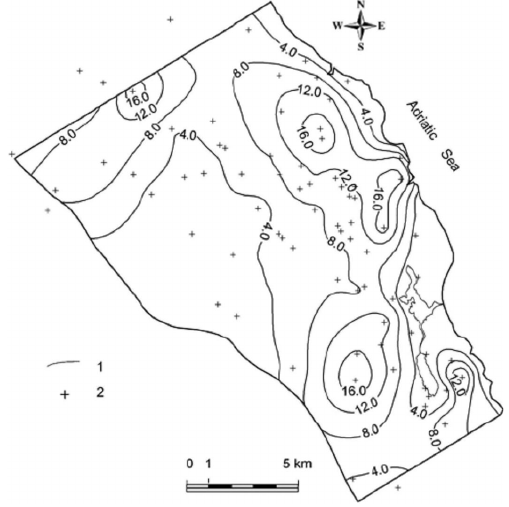
Figure 7: piezometry drawn up with data coming from monitoring campaigns Fig. 7. Piezometry drawn up with data coming from monitoring campaigns.